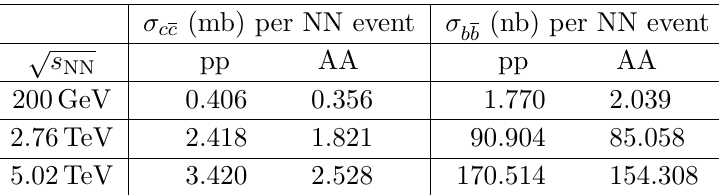
Table 1 . The NLO QQ cross-section in pp and AA collisions provided by POWHEG. EPS09 nPDF’s are employed in the AA